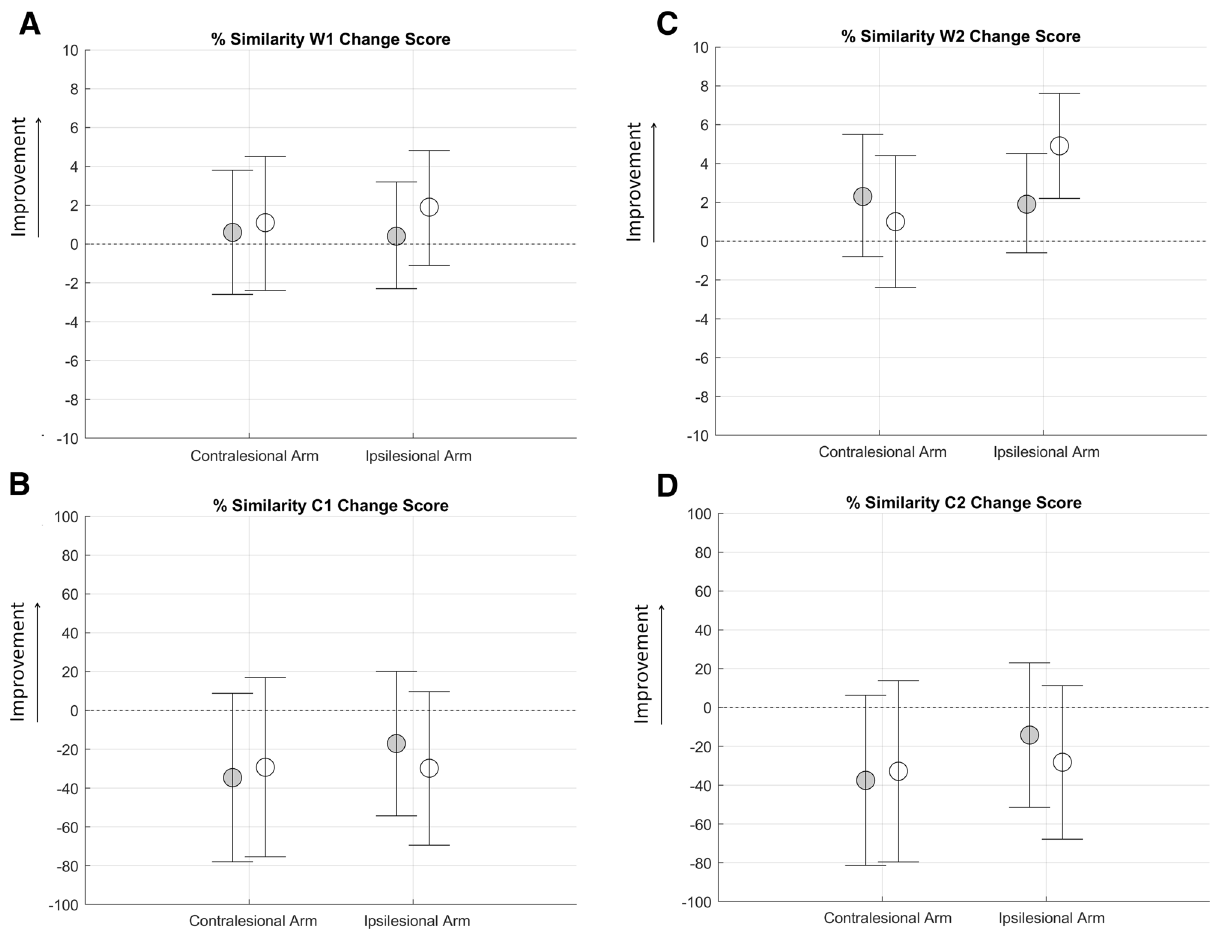
Figure 4. Pre to post change scores from baseline attained by post-stroke participants after robot therapy (RG, white circles) and usual care intervention (UCG, gray circles) during the forearm pronation task for muscle weightings (top panels) and activation profiles (bottom panels) of synergy 1 ( B – D ) and 2 ( C – E ). Circles and whiskers represent, respectively, mean change score and 95% confidence interval adjusted for baseline score through analysis of covariance ANCOVA test. * P < 0.05 (RG vs. UCG, ANCOVA test). + 0.05 ≤ P < 0.1 (RG vs UCG, ANCOVA